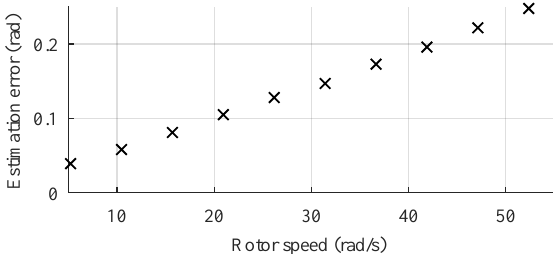
Figure 7. Error committed in the position estimation for different rotor speeds. Angle error expressed in mechanical